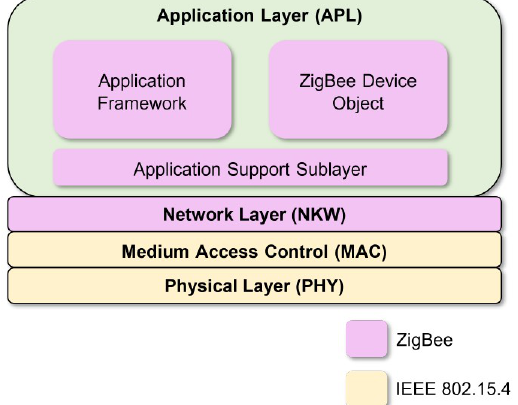
Figure 15. ZigBee stack reproduced with permission from Li, Research and Application of ZigBee Protocol Stack , published by IEEE,